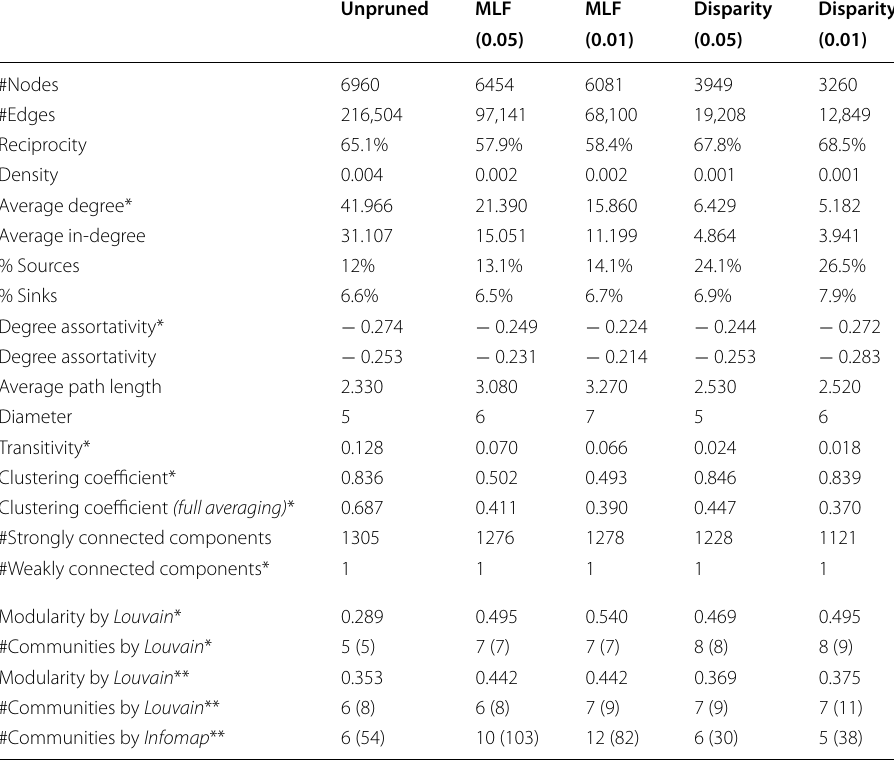
Table 6 Summary of structural characteristics of the I nstancEs network before and after graph pruning. For each of the two graph pruning models, we tested under significance levels at 1% and 5%, which are indicated within